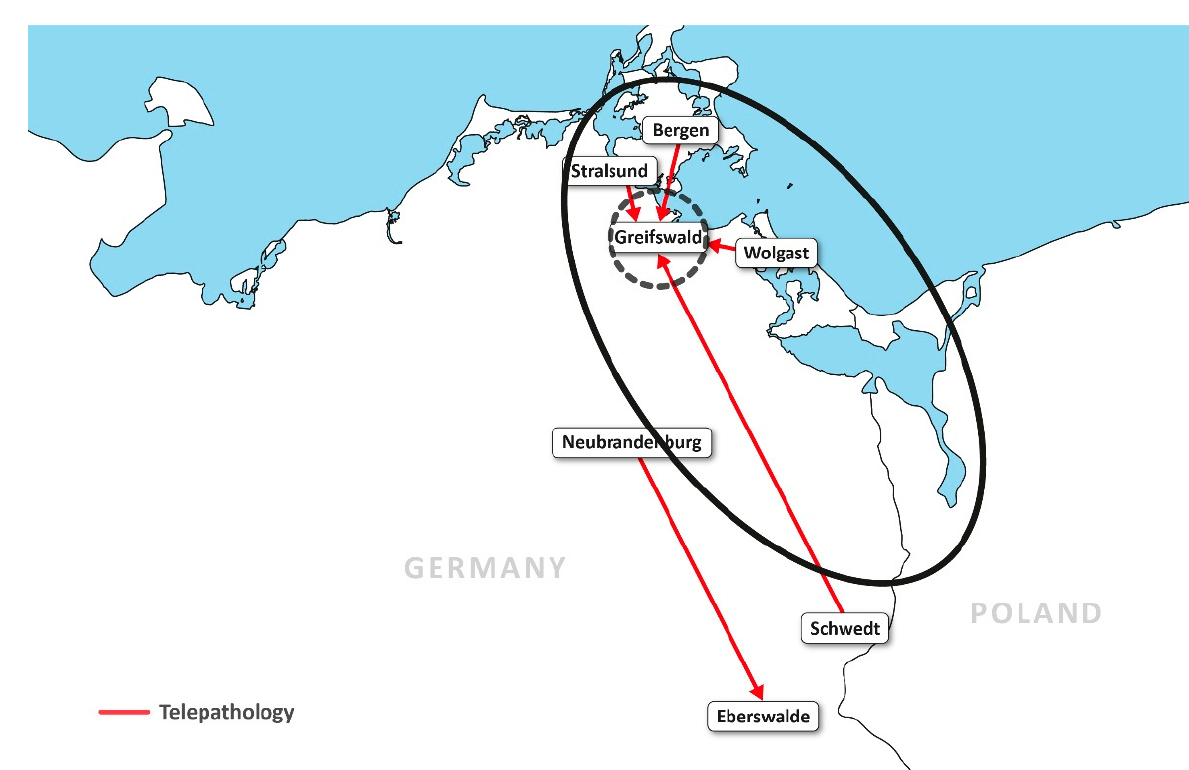
Figure 8. Enlargement of the catchment area of medical facilities through telemedicine. The inner, broken circle shows the direct catchment area of the pathology department at Greifswald University Hospital. Outside working hours, it is limited to the immediate area. Telepathologically, the catchment area is basically unlimited from a purely technical standpoint. The red arrows show telepathology connections in the pathology network.